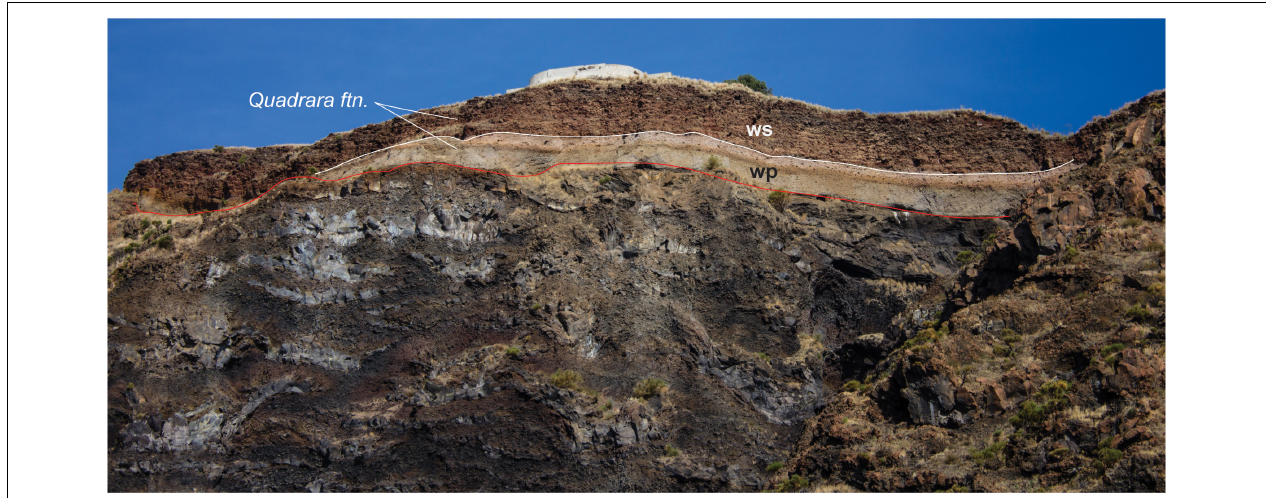
FIGURE 4 | Panoramic view of the Quadrara Formation, in the southernmost area of Vulcano island. Deposit can be divided into the wp (white pumices) and WS (welded scoriae)